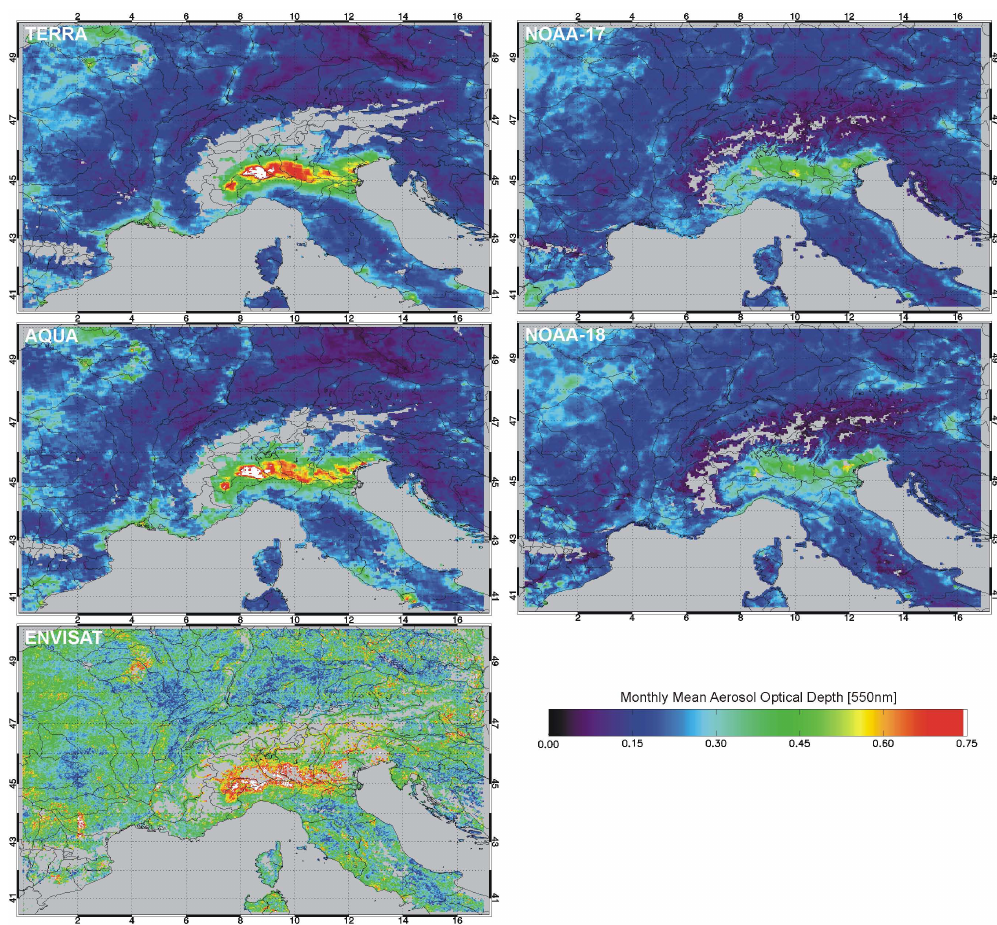
Fig. 6. Example of the monthly mean τ a over land using Terra MODIS, Aqua MODIS, ENVISAT MERIS, NOAA-17 AVHRR and NOAA- 18 AVHRR for the study region (40.5 ◦ N–50 ◦ N, 0 ◦ E–17 ◦ E) in April 2007. Gray areas indicate regions with less than 10% of days with valid values for this particular month or sea